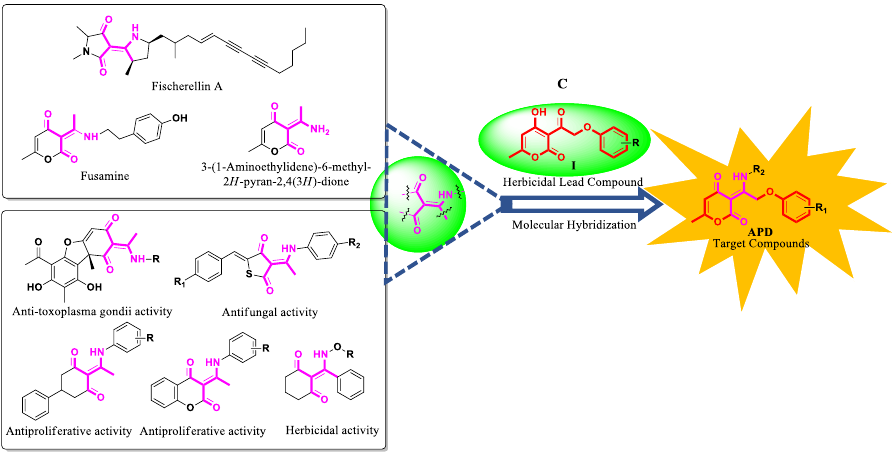
Figure 1. Design of target compound APD based on the molecular hybridization strategy. ( A ) natural product containing enamino diketone skeleton; ( B ) bioactive molecular containing enamino diketone skeleton; (C) the previous reported herbicidal lead compound I.